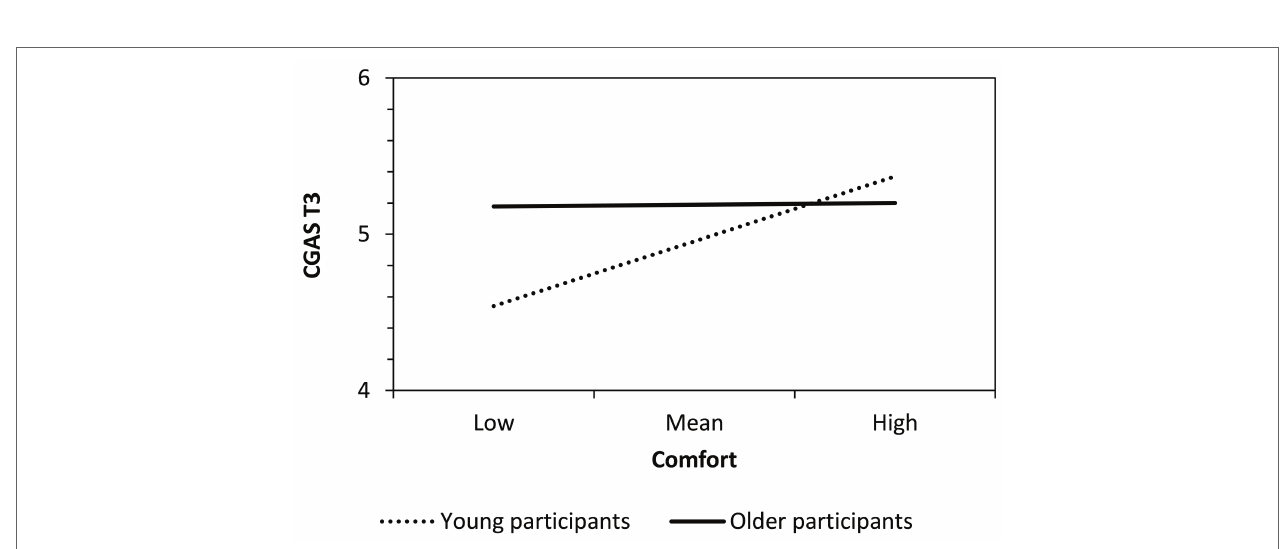
FIGURE 3 | Age-moderated effects of social comfort during the LSEP on T3 CGAS (after controlling for autoregressive T1–T3